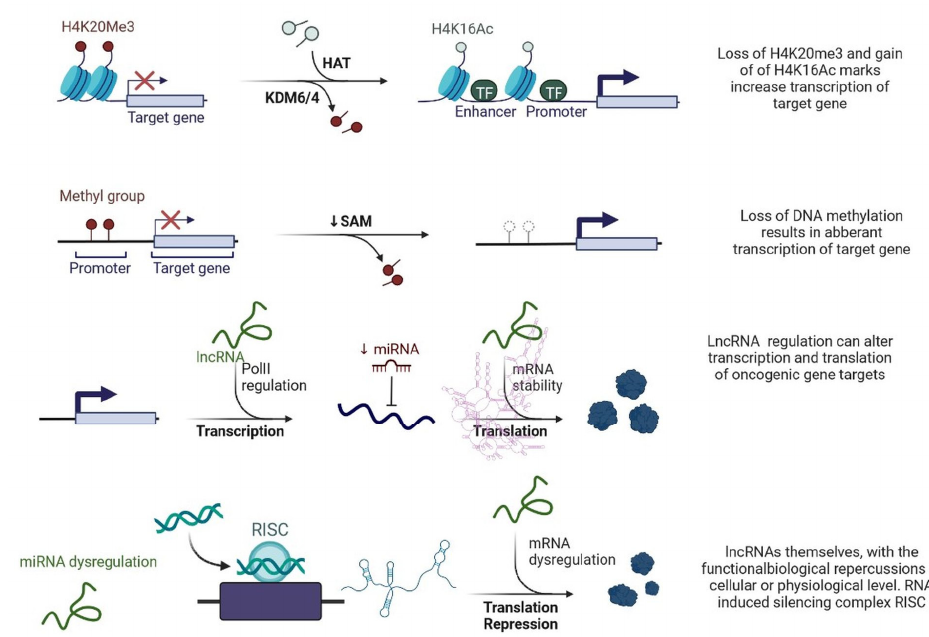
Figure 3. Epigenetic deregulation in cancer including chromatin remodelling, DNA methylation, and non-coding RNA regulation that alters transcription and translation of oncogenic gene targets.